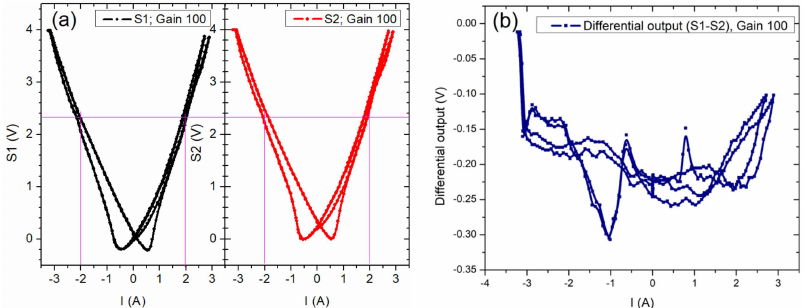
Figure 13. Measured signals on unbiased sensors for: ( a ) individual sensors; ( b ) di ff erential setup. For these tests, the signal was amplified by 100 times.